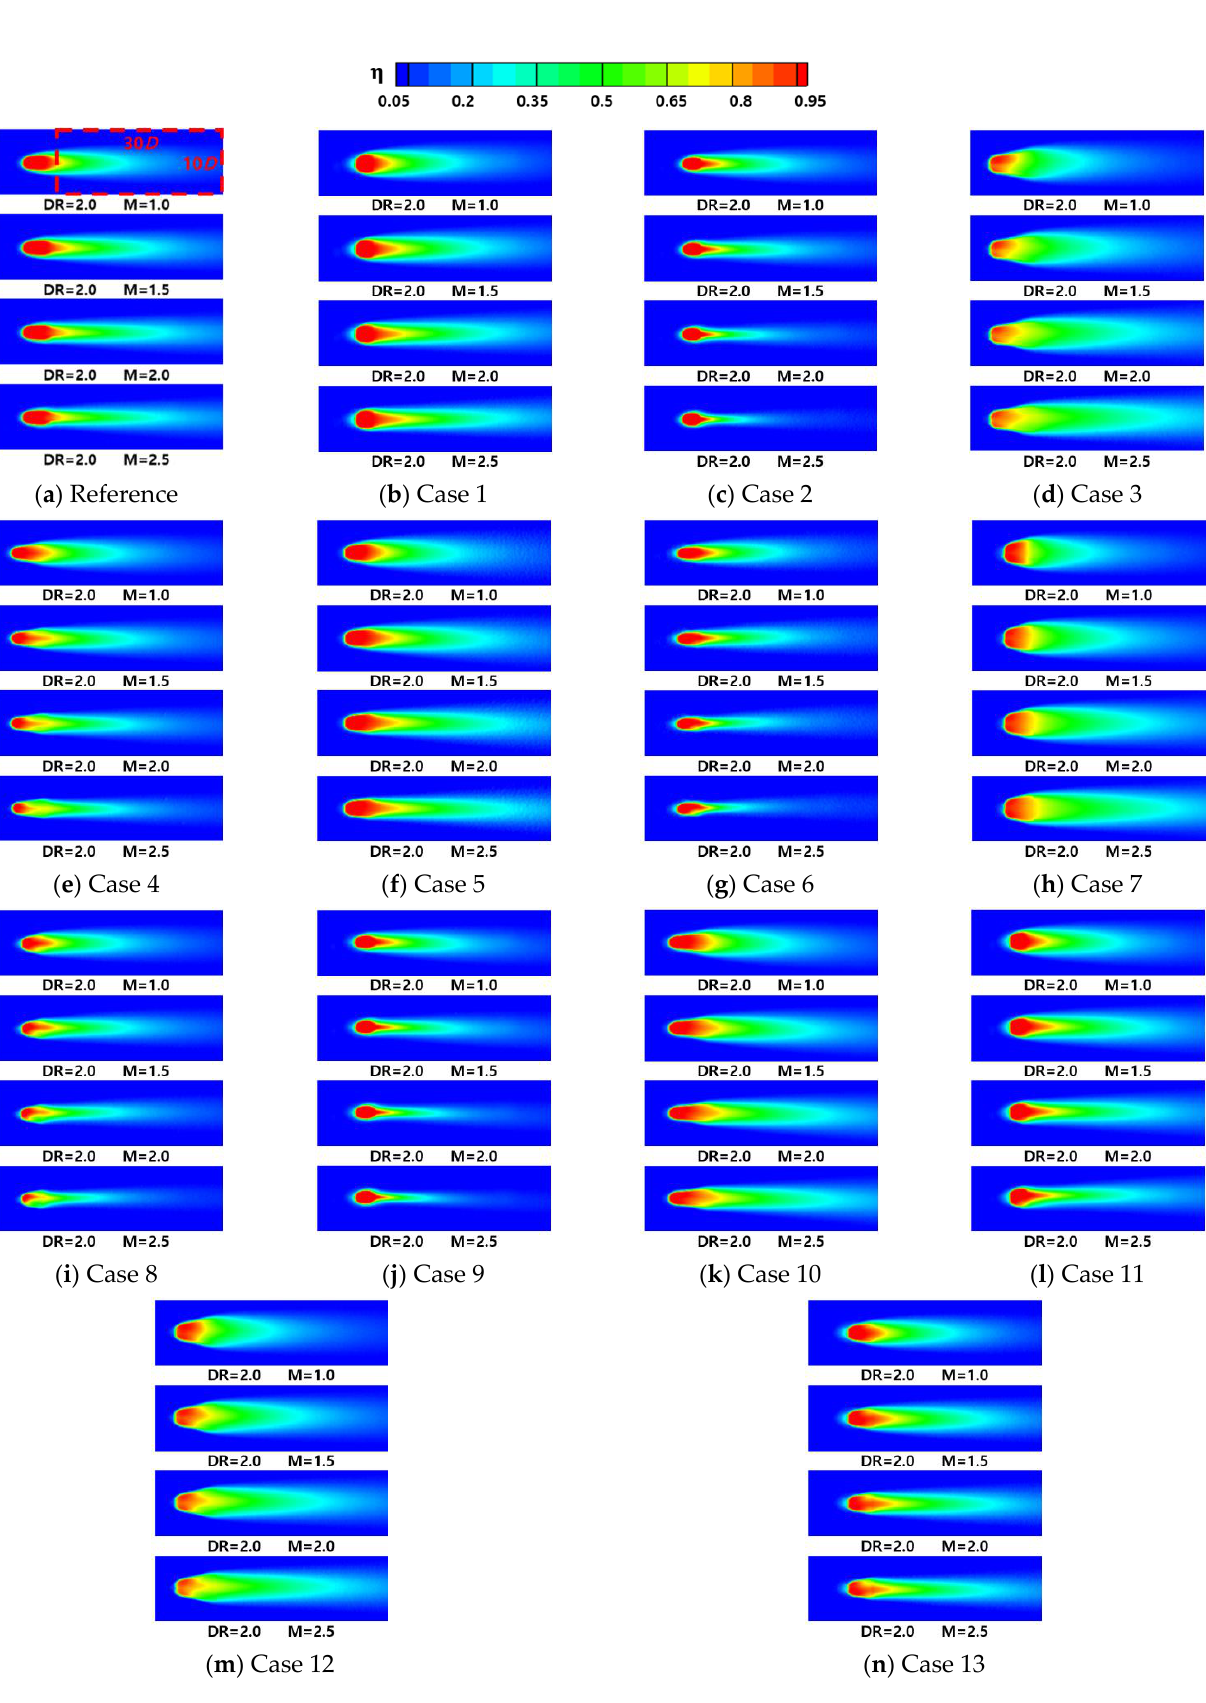
Figure 7. Distribution of the FCE.